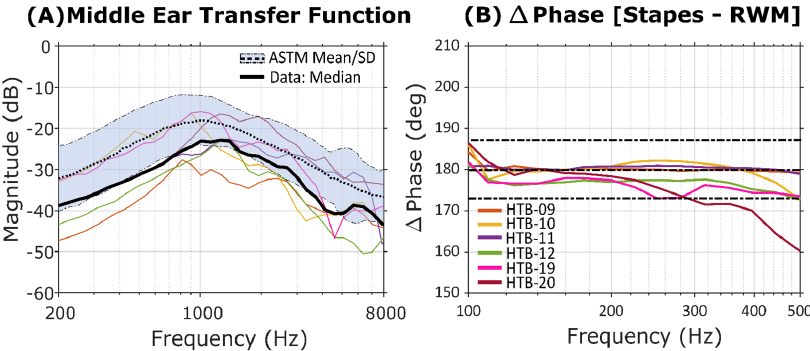
Figure 3. ( A ) METF data of 6 HTBs compared with the ASTM F2504e05 standard. The dotted black line represents the mean ASTM F2504e05 standard and the 95% confidence interval is in blue. The thick black line corresponds to the median of 6 HTBs. ( B ) Phase difference between stapes and RWM for six HTBs in the lower frequency range (100–500 Hz). The dotted black lines represent the ±7.2° deviation band from a 180° phase difference similar to the study of Frear et al. (2018) [19]. Each HTB sample is represented by a specific color.